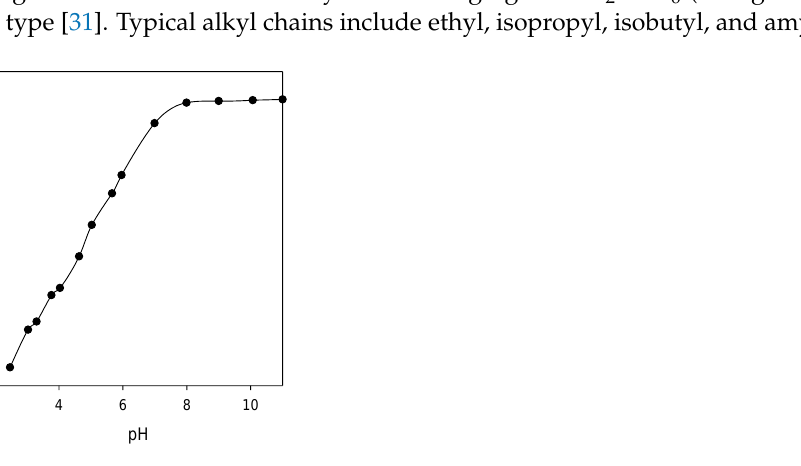
Figure 10. Formation of carbon sulfide at different pH values from 0.05 wt% SIBX solution (adapted from Shen et al. [33]). Xanthate collector forms an insoluble and hydrophobic compound with polyvalent metals (metallic xanthate compounds), and its oxidation can form dixanthogen (see Figure 11). Dixanthogen is an insoluble and highly hydrophobic oil that adsorbs on sulfurous surfaces, improving their floatability. Figure 11. Formation of dixanthogen. According to the literature, the most common mechanism of interaction between xan- thate and sulfides is electrochemical [34]. Xanthate ions are oxidized to dixanthogen or metal xanthate. Dioxanthogen is not a selective reagent, unlike sulfur, which has a high affinity for copper.